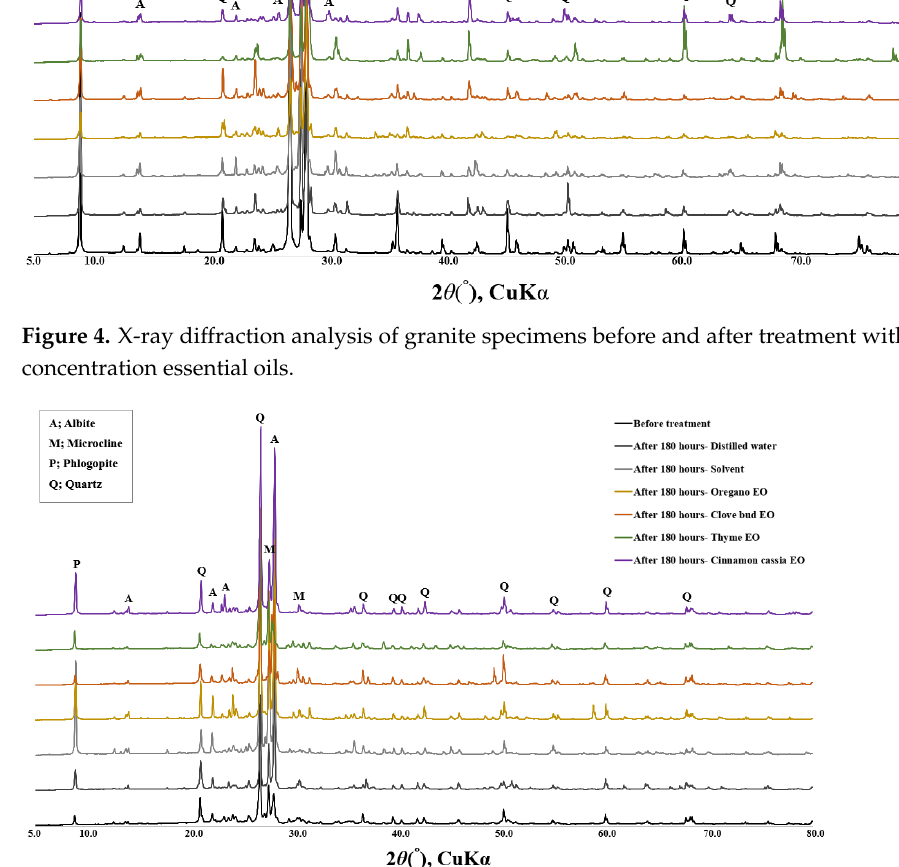
Figure 5. X-ray diffraction analysis of gneiss specimens before and after treatment with 10% low- concentration essential oils.